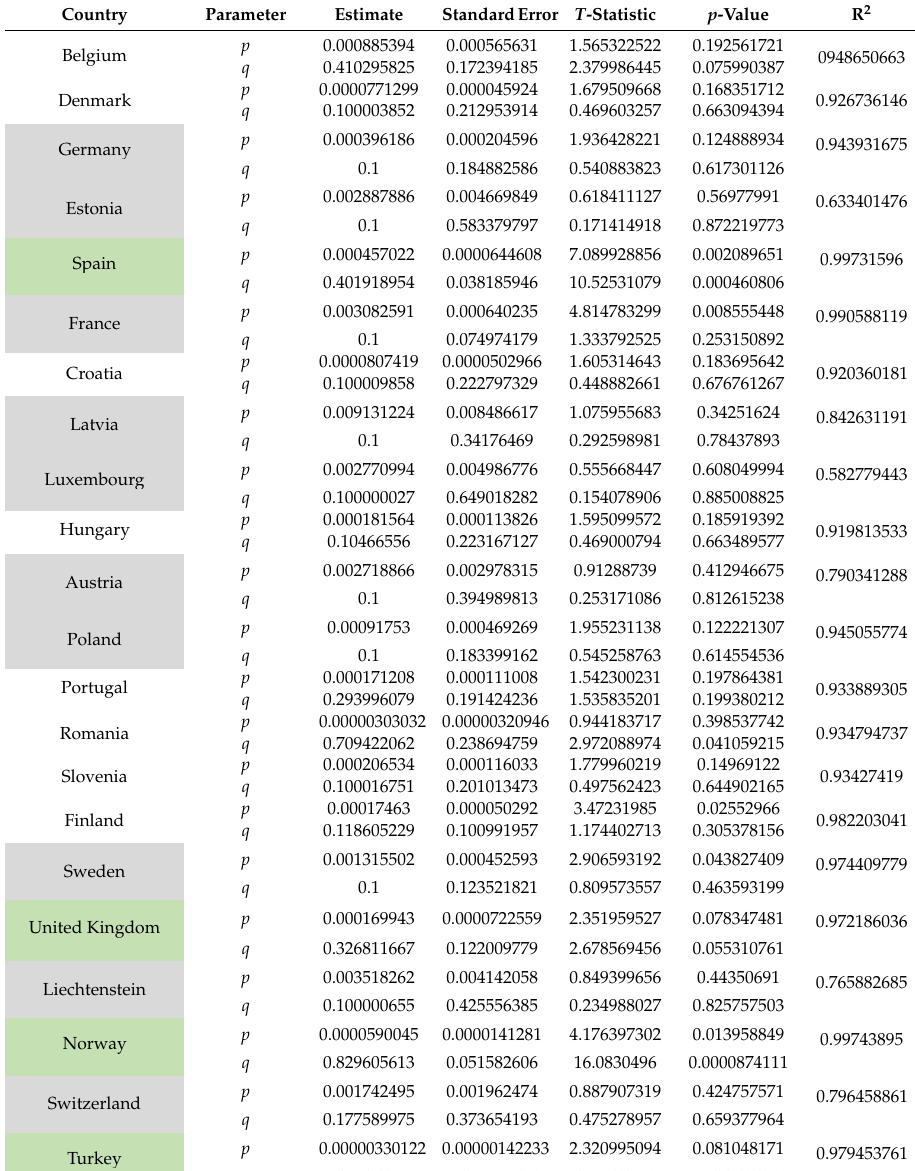
Table 3. Estimation of Bass model parameters for EU countries [Source: own study based on data retrieved from Eurostat]. Parameter